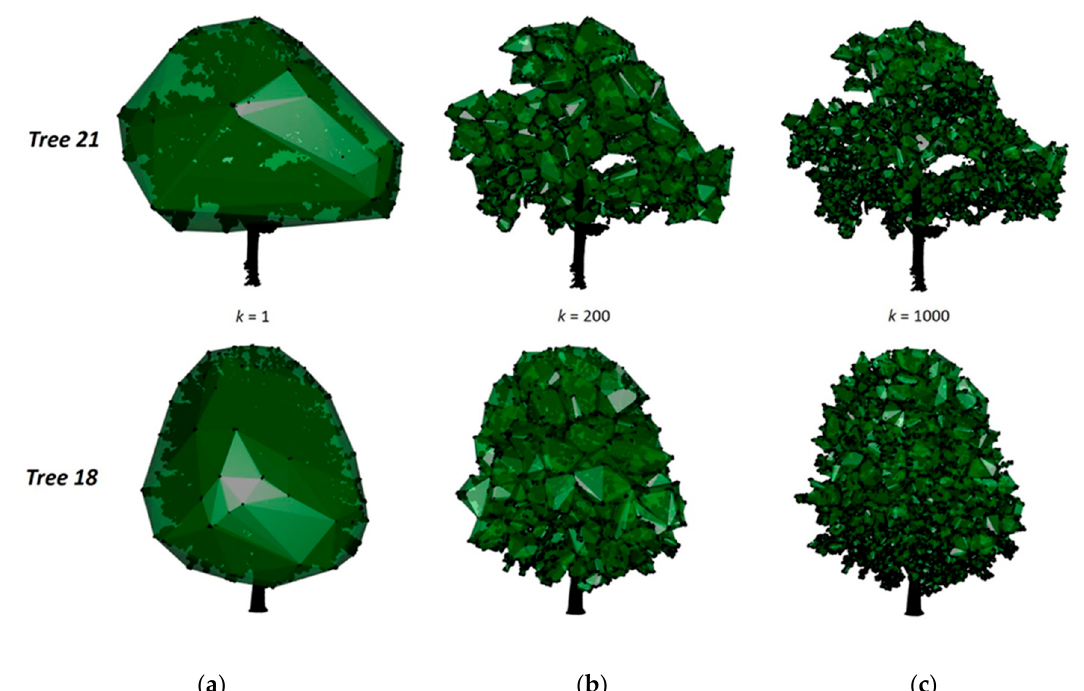
Figure 6. Illustration of the k -means clustering approach to generate hulls of green volume within the crown (sample Tree 21 and Tree 18): convex hulls were wrapped around: ( a ) k = 1 cluster (wrapping total crown volume); ( b ) k = 200 clusters; and ( c ) k = 1000. “Leaf clusters” can be seen more evenly distributed in the crown of Tree 18 than of Tree 21.